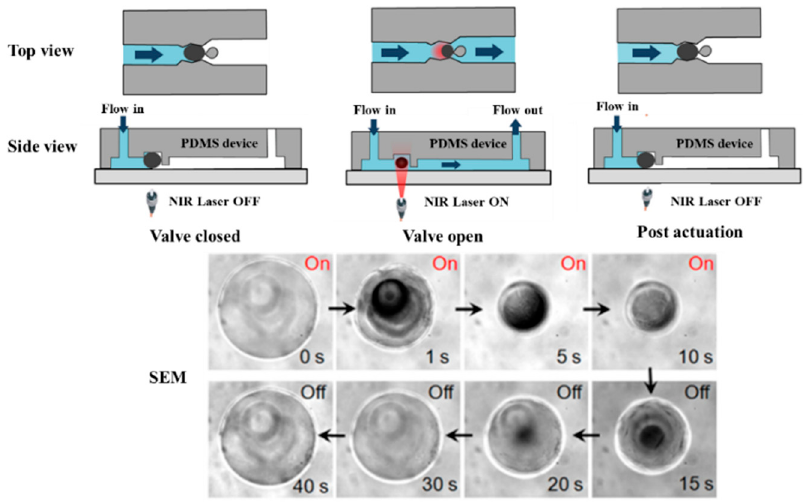
Figure 13. Schematic and SEM of photoresponsive hydrogel microvalve [97].